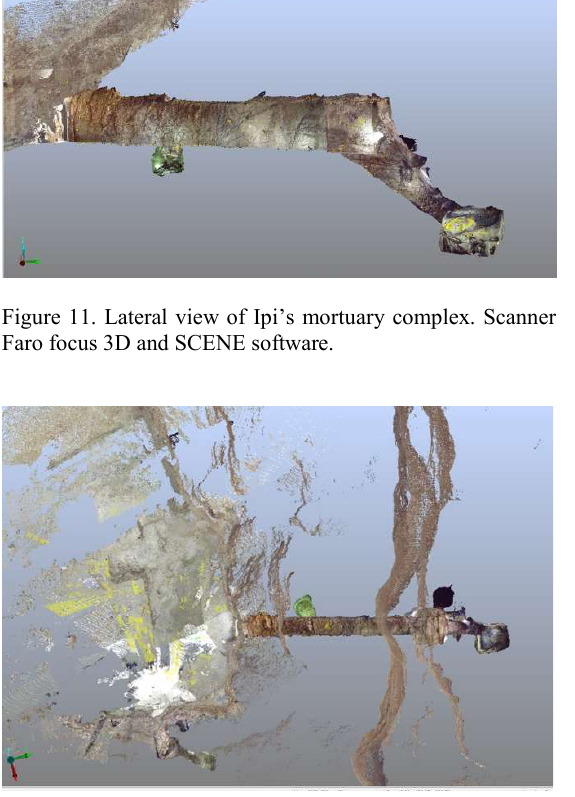
Figure 12. Outdoor view of Ipi’s courtyard. Scanner Faro focus 3D and SCENE